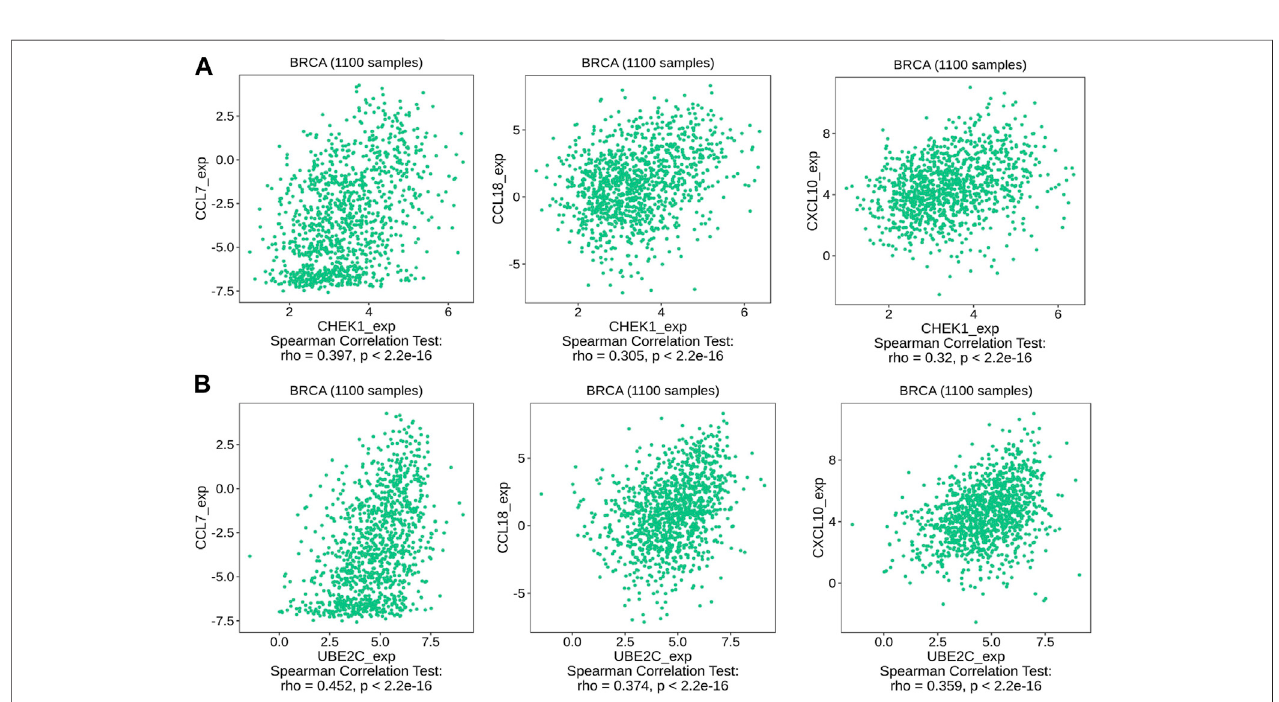
FIGURE7| RelationsbetweentheexpressionofthetwohubgenesandchemokinesofCCL7,CCL18,CXCL10. (A) Relationsbetweenexpression ofCHEK1and three chemokines in BRCA. (B) Relations between expression of UBE2C and three chemokines in BRCA.